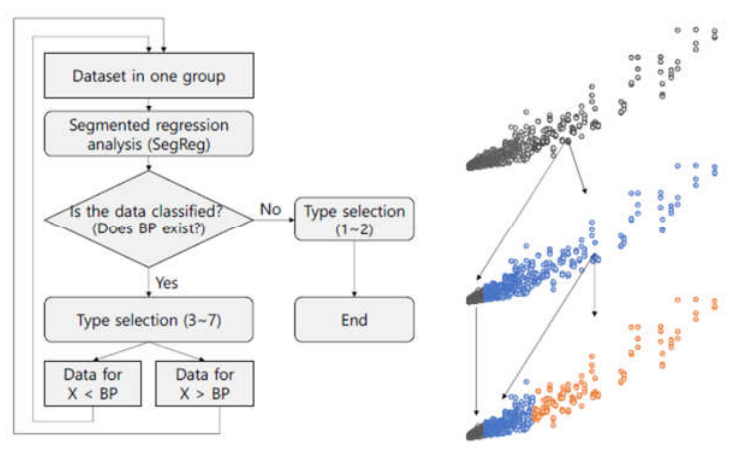
Figure 3. The procedure and method of data classification using SegReg program. Table 5. Linear regression analysis result.